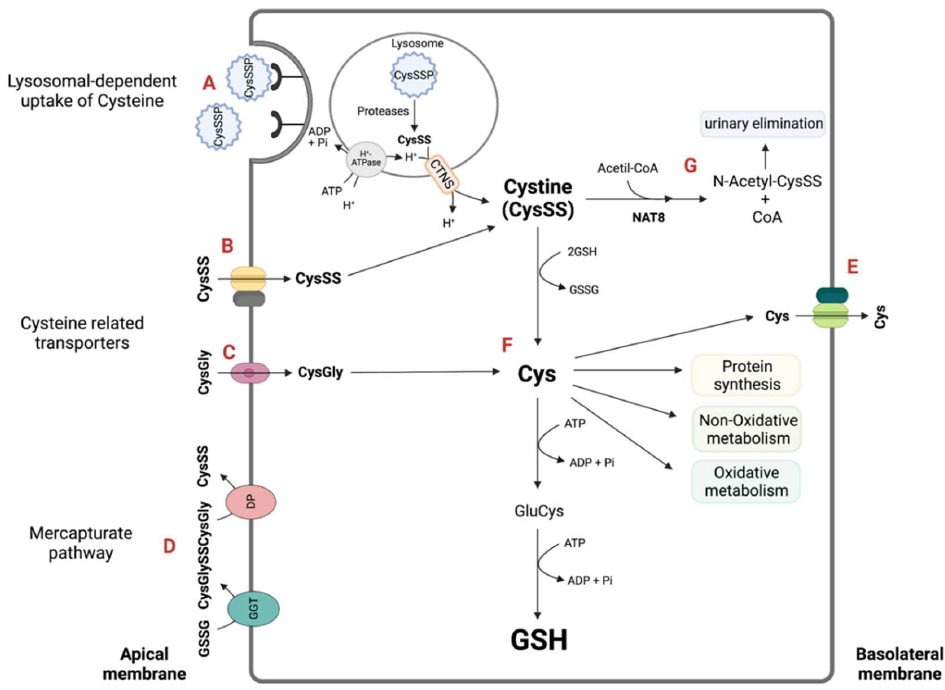
Figure 1. Cysteine supply and metabolic circuits for the renal epithelial proximal tubular cells. The net intracellular supply of cysteine is a sum of different contributions. After glomerular filtration, there is an increase in the proximal tubule luminal content of CysSSP and also of glutathione (can